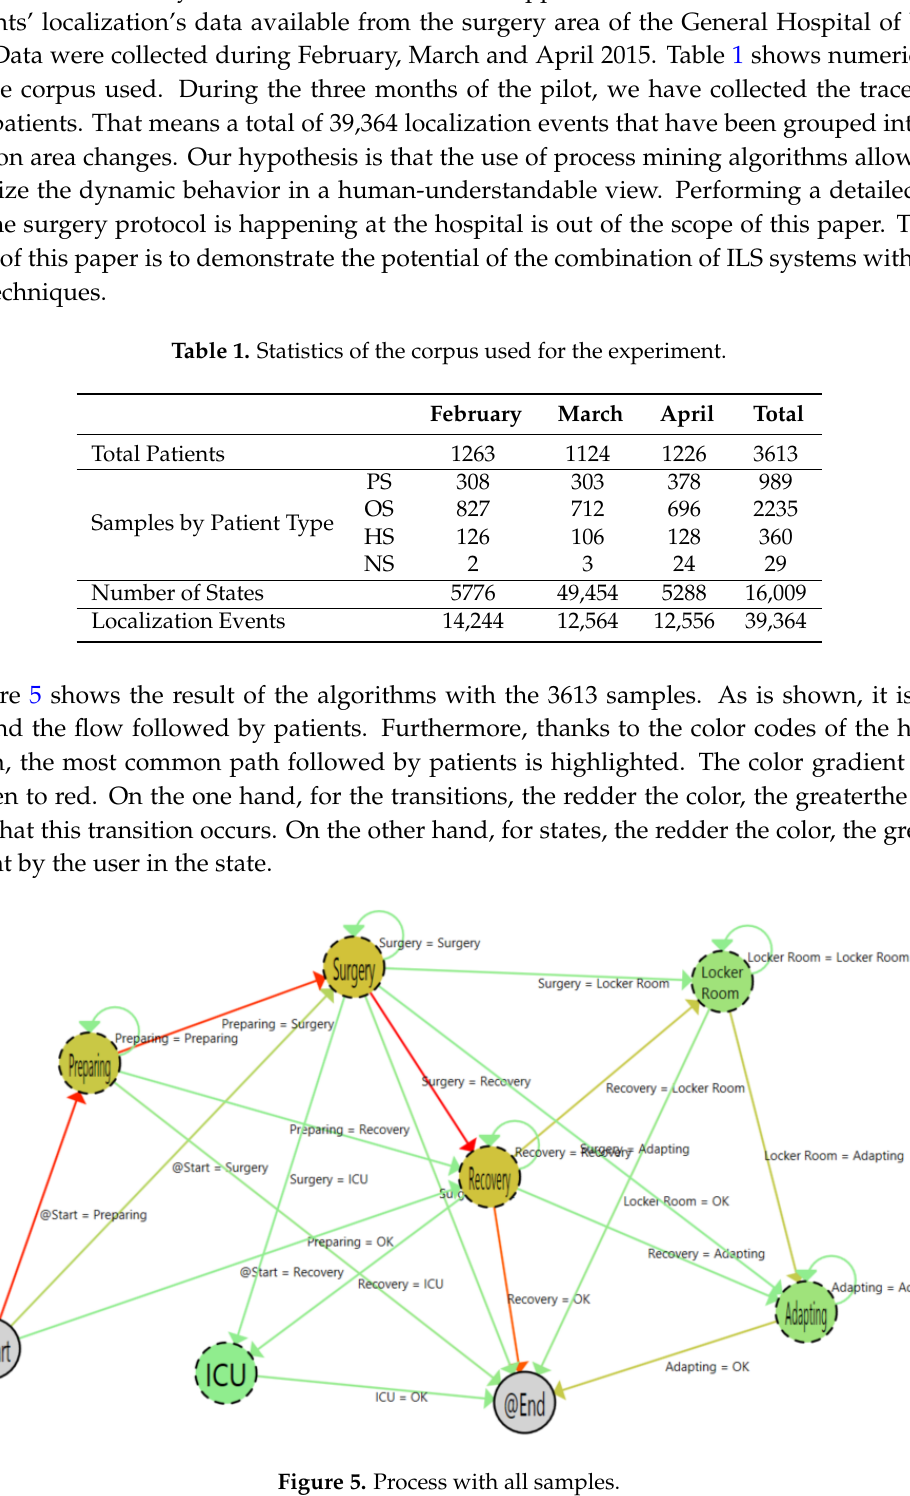
Figure 5. Process with all